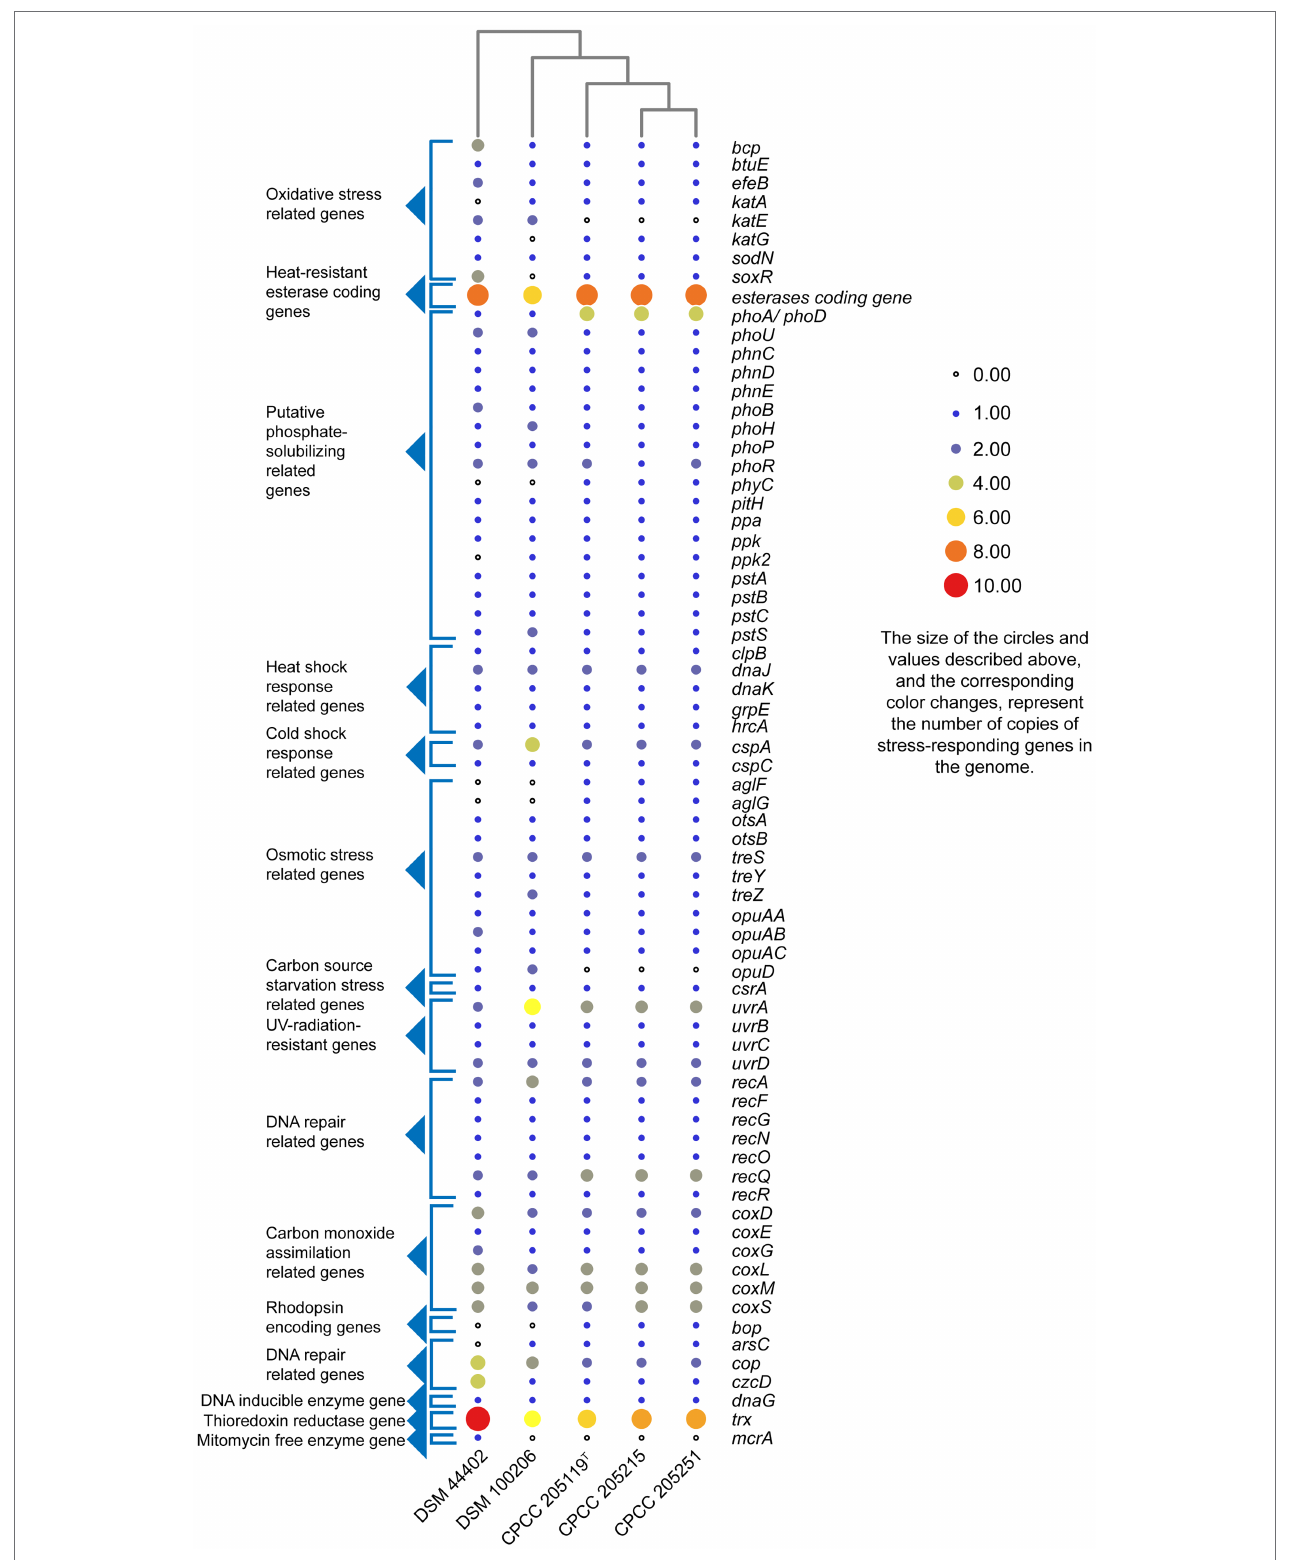
FIGURE 2 | Heatmap of putative stress-responding genes predicted in the genomes of strains CPCC 205119 T , CPCC 205215, CPCC 205251, and their closest phylogenic neighbors according to the copy number of the genes from the Rapid Annotation using Subsystem Technology (RAST)